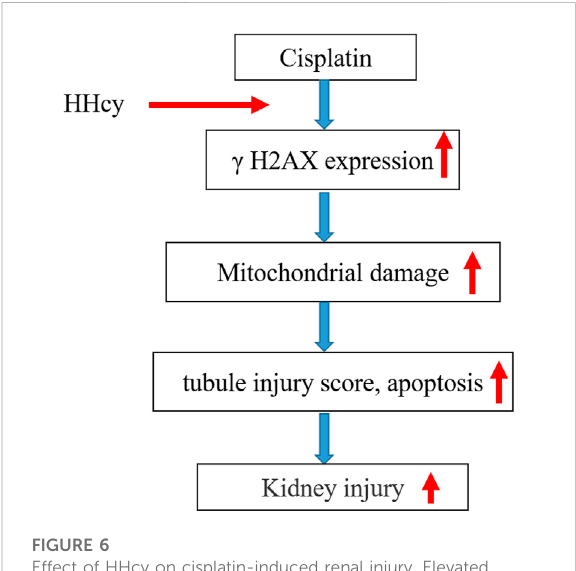
FIGURE 6 Effect of HHcy on cisplatin-induced renal injury. Elevated plasma homocysteine levels might aggravate DNA damage; this activates mitochondrial damage signaling pathways that further promote kidney